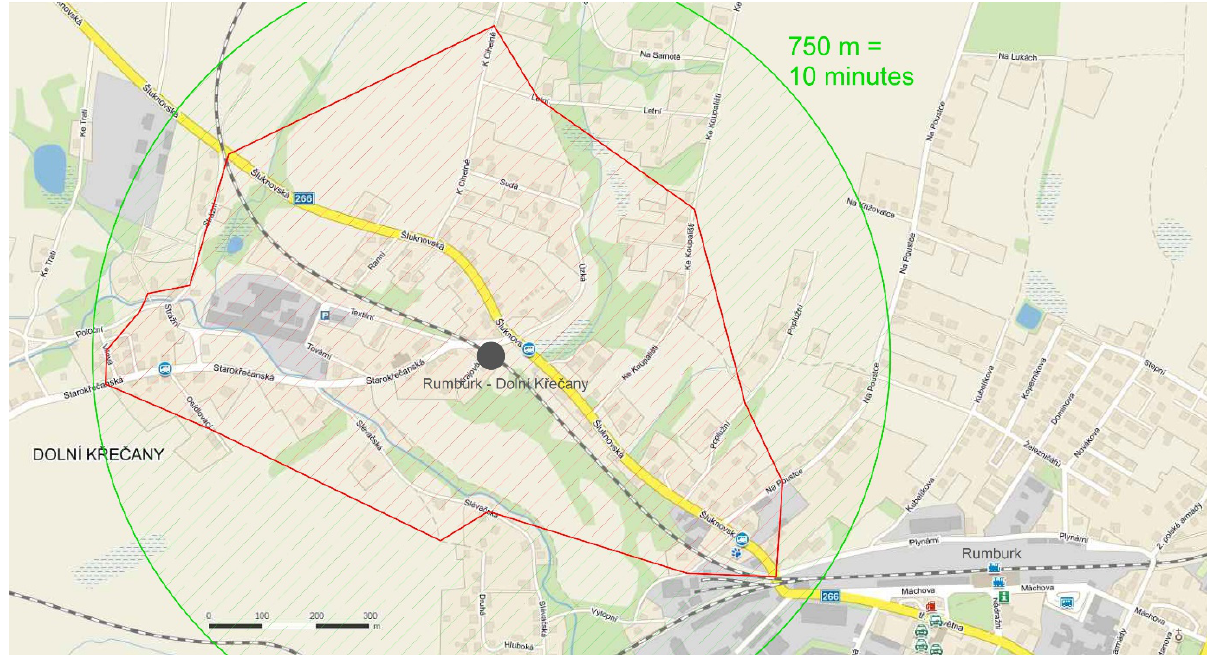
Figure 4. Proposed location of the new stop Rumburk-Dolní